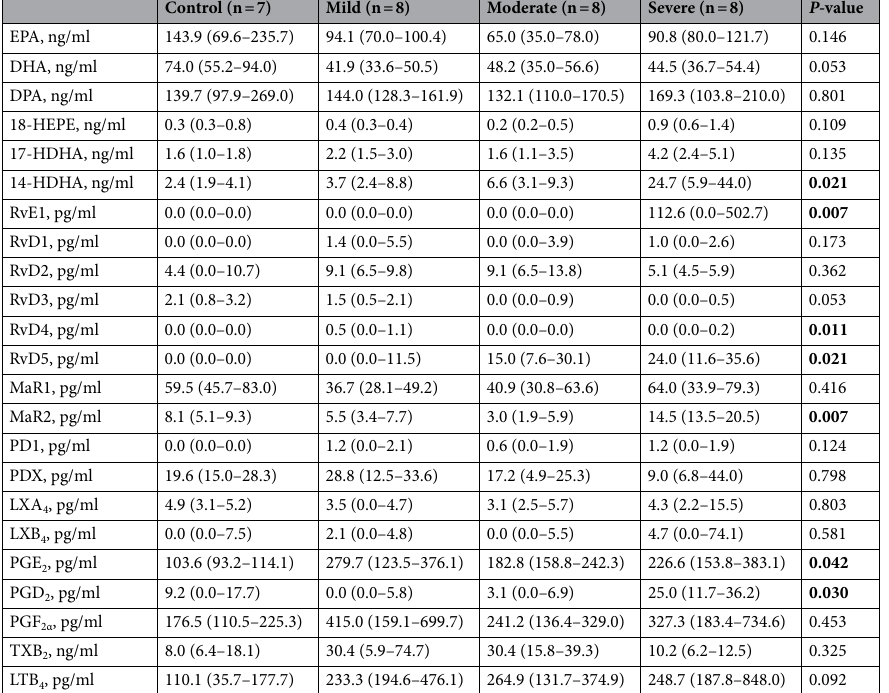
Table 3. Active lipid mediators and the precursor w-3 PUFA in controls and COVID-19 groups. Data expressed as median (25th–75th percentile); Statistical analysis by Kruskal–Wallis test, P < 0.05 was considered statistically significant. When lipids were not detected in samples, an arbitrary value of 0.001 was used for statistical analysis 32 . Abbreviations: eicosapentaenoic acid (EPA), docosahexaenoic acid (DHA), docosapentaenoic acid (DPA), hydroxyeicosapentaenoic acid (HEPE), hydroxy docosahexaenoic acid (HDHA), resolvin (Rv), maresin (MaR), protectin (PD), lipoxin (LX), prostaglandin (PG), tromboxane (TX), and leukotriene (LT). Significant values are in